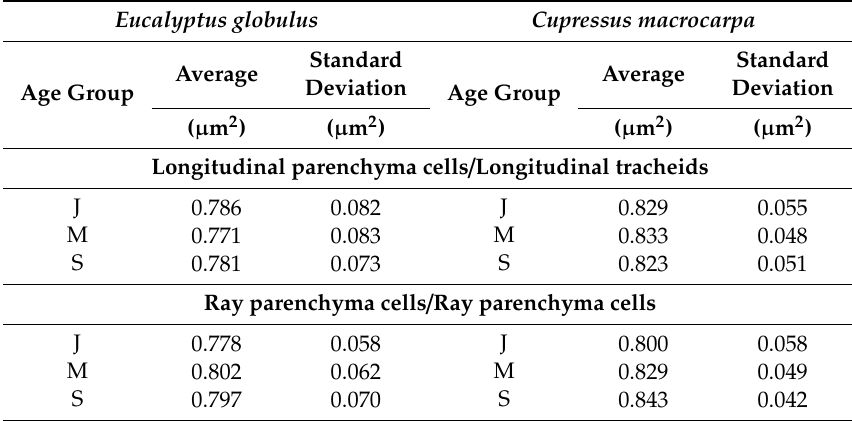
Table 3. Averages and standard deviations of sphericity of the longitudinal parenchyma cells, longitudinal tracheids and ray parenchyma cells for Eucalyptus globulus and Cupressus macrocarpa per age